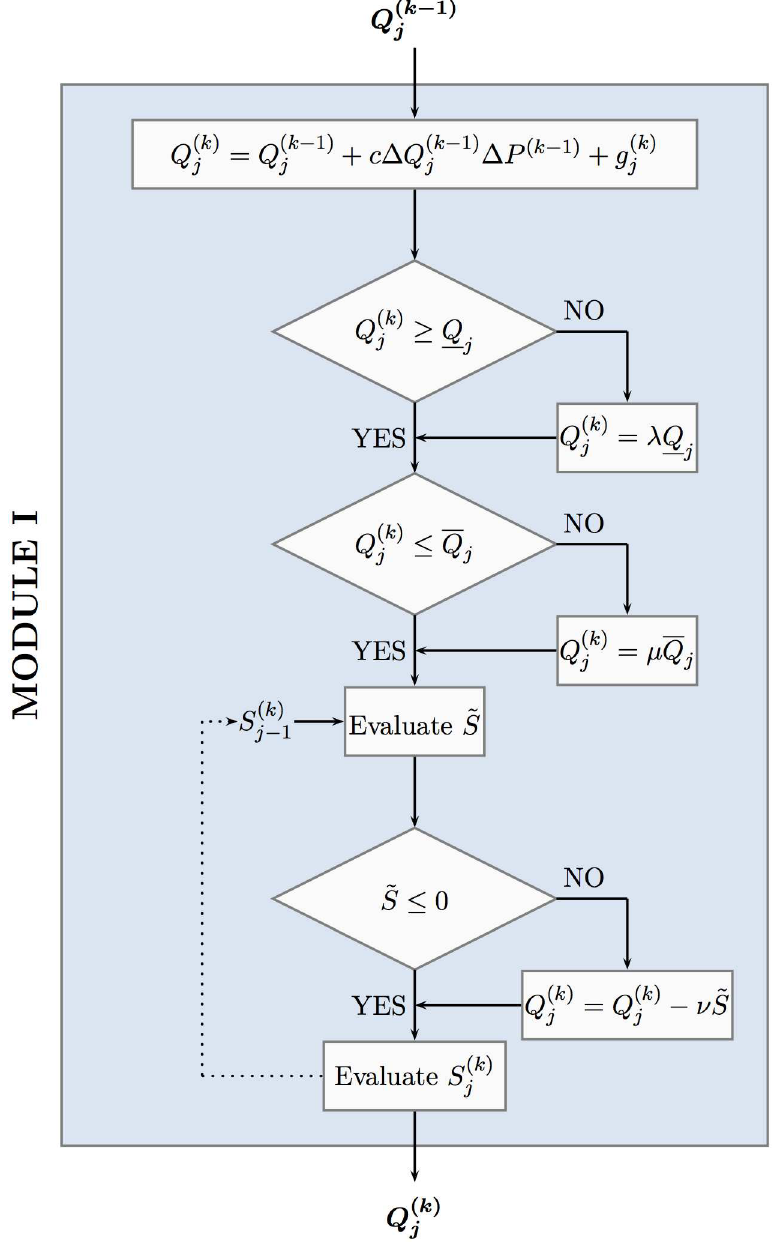
Fig 6. Flow chart of MODULE